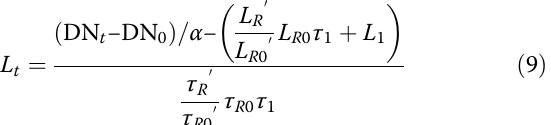
Fig. 5 Grayscale of field test